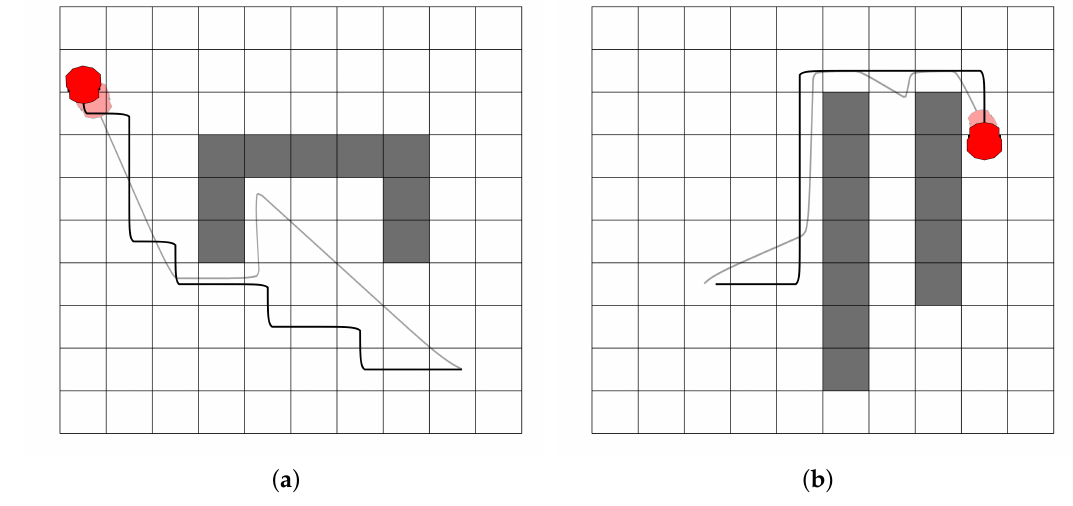
Figure 4. Comparison with the ( a ) firefly algorithm by Patle in [12] and ( b ) Matrix-Binary Codes based Genetic Algorithm (MGA) controller by Patle in